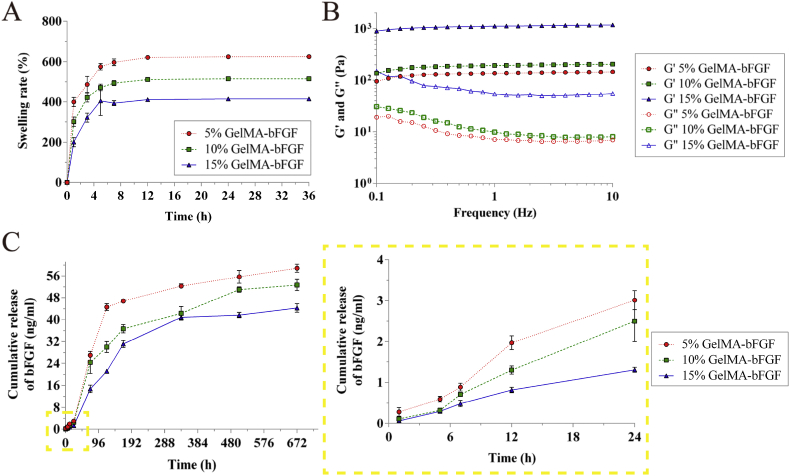
Swelling ratio, mechanical property and bFGF release profile of GelMA-bFGF hydrogels. (A) The degree of swelling of GelMA-bFGF hydrogels. (B) Frequency sweep test of GelMA-bFGF hydrogels, elastic (storage) modulus G′ and the viscous (loss) modulus G″ at the strain rate of 0.1%. (C) The bFGF release profile of GelMA-bFGF hydrogels in 28 days and a zoom in graph of release in the first 24 h.